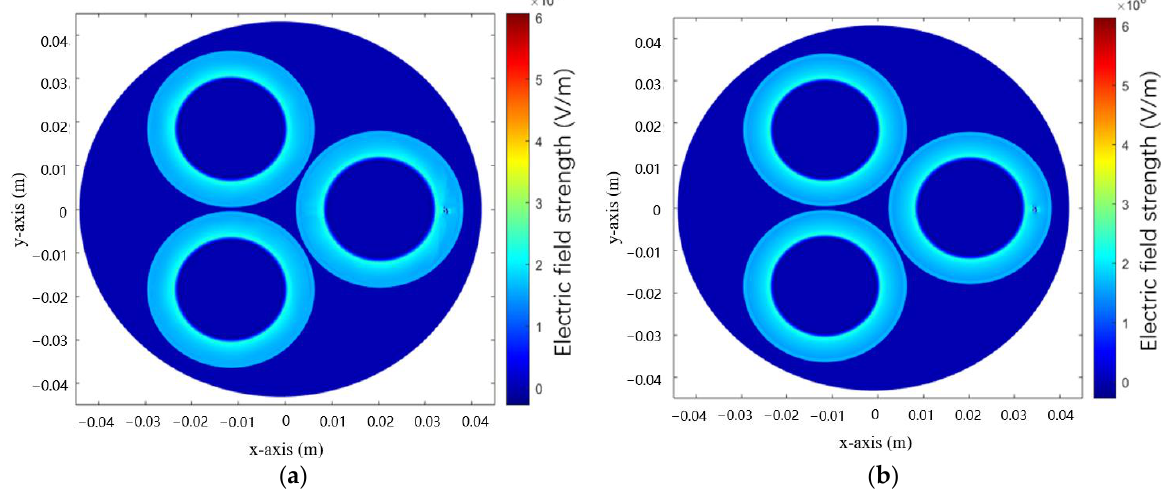
Figure 6. Comparison of calculated values of the data-driven model with finite element method for changing voltage parameters, ( a ) Electric field strength calculated by data-driven model, ( b ) Electric field strength calculated by finite element.